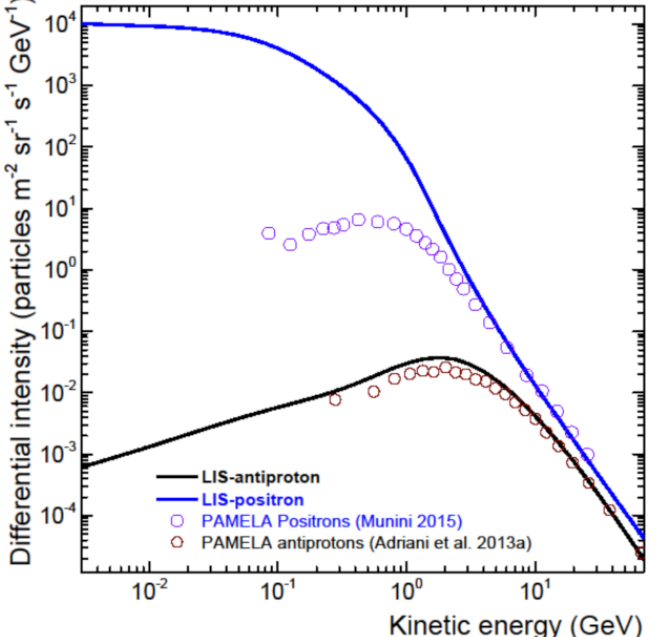
Figure 21. Computed VLISs for galactic positrons (solid blue line) and anti-protons (solid black line) along with observations from PAMELA [113,152] here averaged over 2006–2009, as examples of modulated positron and anti-proton spectra at the Earth based on the total modulation from 1 AU to the HP at 122 AU during solar minimum